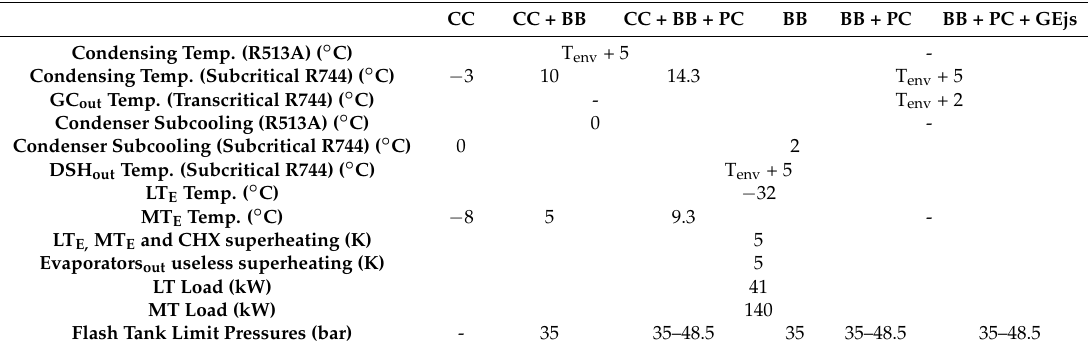
Table 1. Summary data